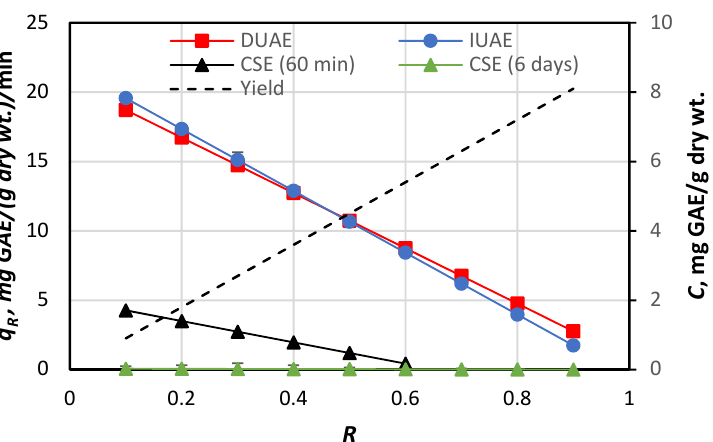
Figure 4. Extraction rates, q R , at given values of recovery ratio, R , and resultant yield, C , for the three extraction methods tested in the present study. q R is calculated using Equation (8) and data given in Table 1 assuming that C Max = 9.0 mg GAE/g dry wt. The solid lines with markers are the q R curves, and the dash line is the C curve.